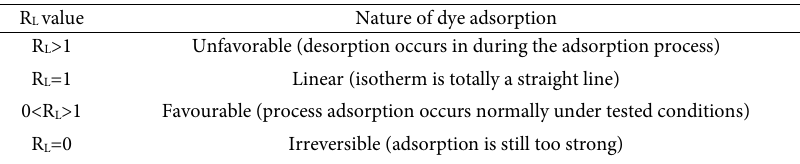
Table 1: R L values for determination of the nature of dye adsorption Table 1: R values for determination of the nature of dye L